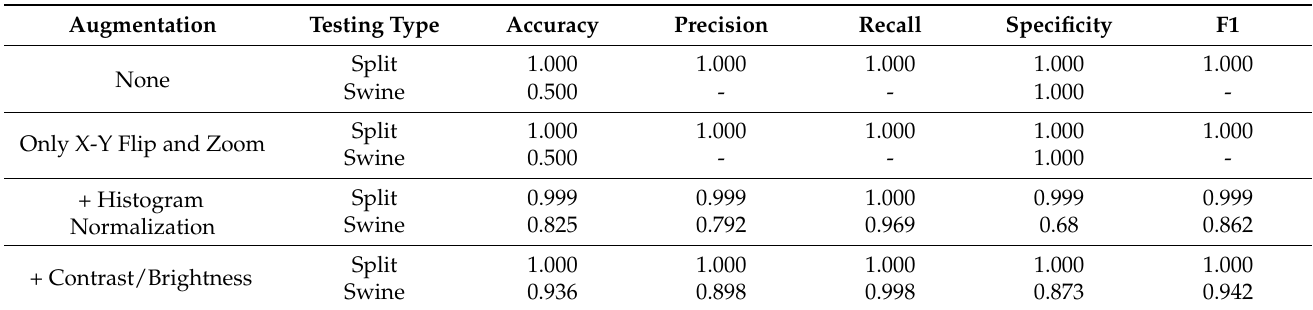
Table 1. Summary of model performance metrics. Results are shown for each image augmentation methodology for phantom split test data sets and swine test image sets. Augmentation steps follow the pathway described in Figure